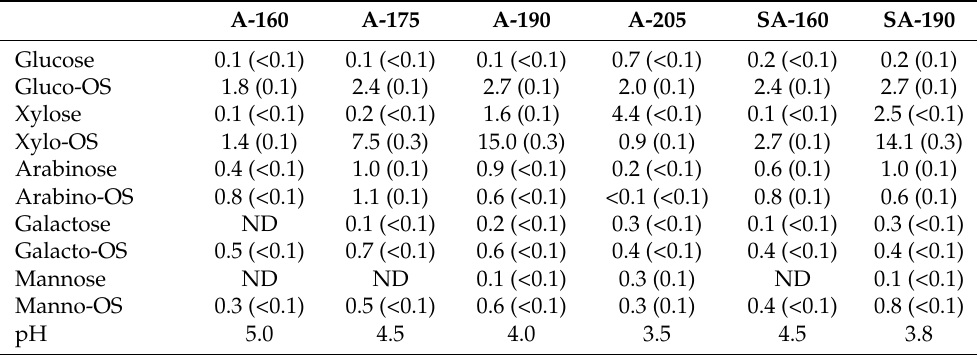
Table 3. Concentrations of monosaccharides and oligosaccharides (OS) (g/L) and pH in the pretreat- ment liquids a